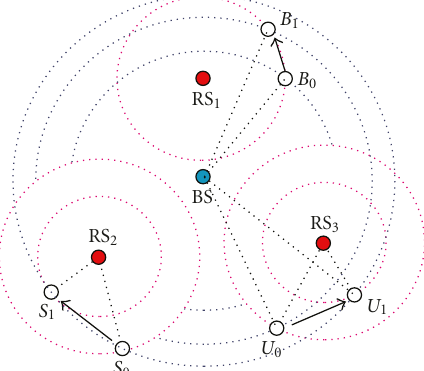
Figure 1: Three examples of channel gain change according to movement of mobile station (MS). Case 1 ( B 0 → B 1 ): MS goes away from BS with RS-MS distance constant. The channel gain between RS and MS increases but it does not increase the achievable rate between MS and BS. Case 2 ( S 0 → S 1 ): MS gets close to RS with BS-MS distance constant. The channel gain between BS and MS decreases and it decreases the achievable rate between BS and MS. Case 3 ( U 0 → U 1 ): MS gets close to RS whereas it goes away from BS. The channel gain between RS and MS increases but the channel gain between BS and MS decreases, which finally decreases the achievable rate between BS and